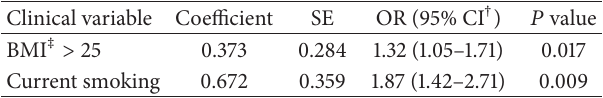
Table 3: Independent risk factors for the development of colorectal hyperplastic